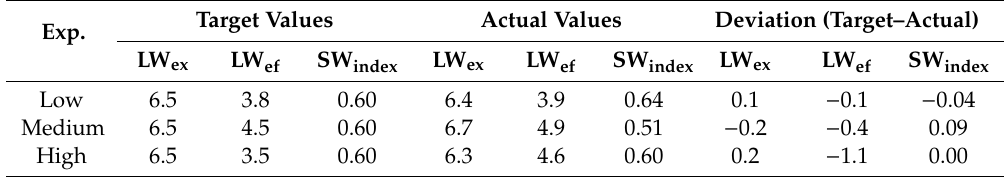
Table 10. Geometric characterization of the walls built for validations